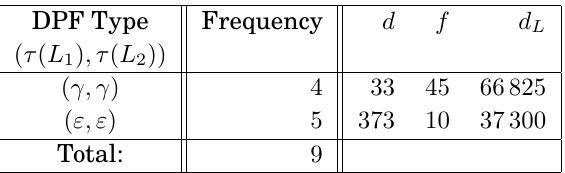
Table 3: Types of doublets in the range 0 < d L < 10 5 .